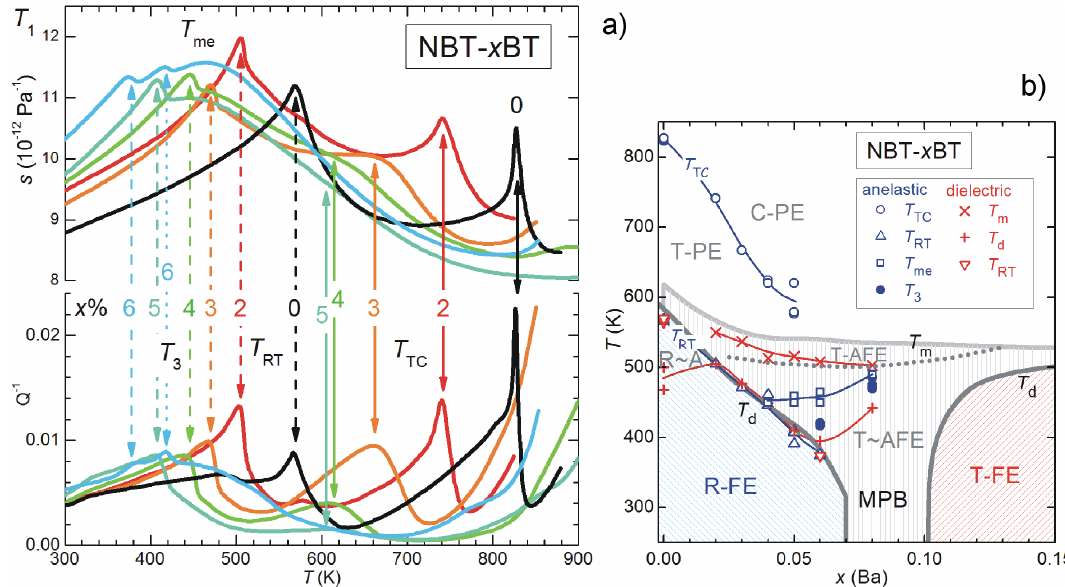
Figure 17. ( a ) compliance s (reciprocal Young’s modulus) and elastic energy loss coefficient Q − 1 of various compositions of NBT − x BT measured with the free flexural resonance at 1–5 kHz during heating. The solid arrows indicate T TC , the dashed arrows T RT and the dotted arrow T 3 . ( b ) phase diagram deduced from the anelastic and dielectric spectra [172]; the gray lines are from [160] for x < 0.07 and from [173] for x >